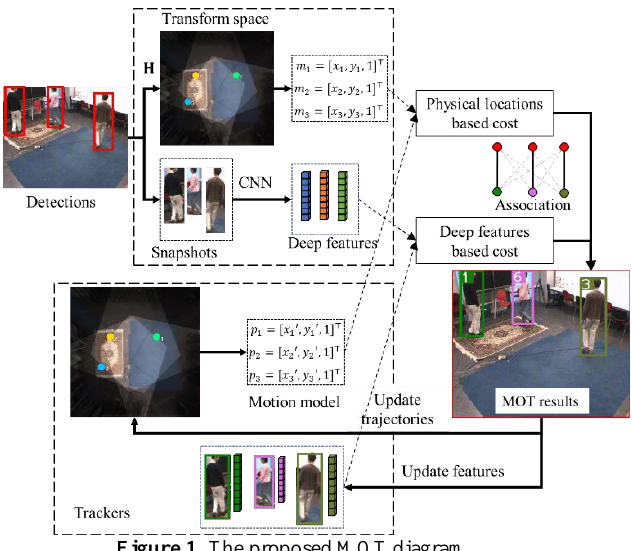
Figure 1. The proposed MOT